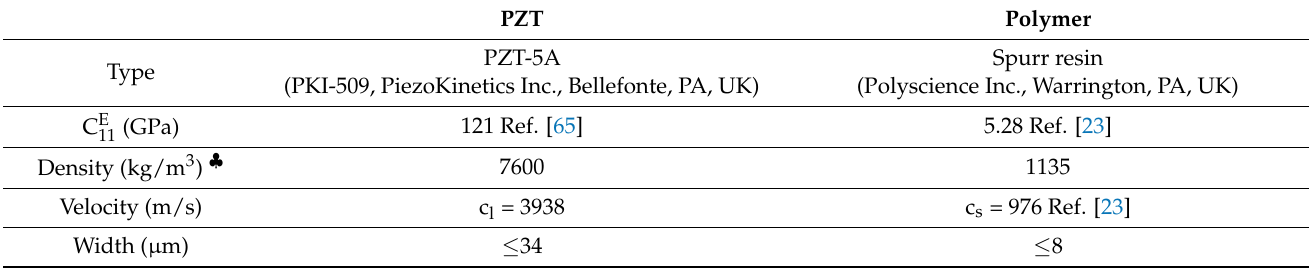
Table 2. Material properties used to determine dimensions of the ceramic–polymer 2-2 composite using Equations (1)–(3). PZT Polymer Type